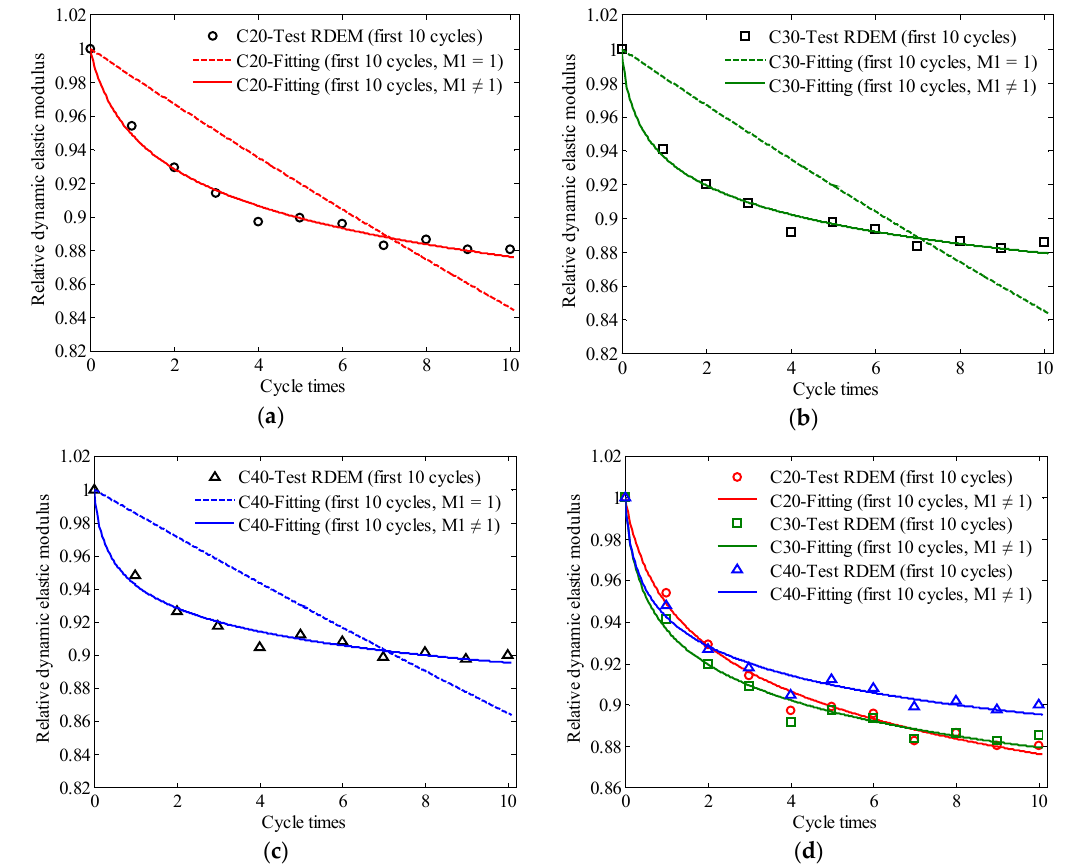
Figure 6. Fitting results of dynamic elastic modulus degradation model based on the initial and first 10 instances of periodic temperature-humidity action: ( a ) C20; ( b ) C30; ( c ) C40; ( d ) two-parameter degradation model for concrete with strength grades of C20, C30, and C40. (Note: C20, C30 and C40 means the concrete with different strength grade of 20MPa, 30MPa and 40MPa; ‘Test RDEM’ means the data is from the relative dynamic elastic modulus test results; ‘Fitting’ means the data is from fitting analysis; ‘M1 = 1’ means the fitting analysis is based on the single parameter model, see Equation (11); ‘M1 (cid:44) 1’ means the fitting analysis is based on the two-parameter model, see Equation (12), ‘first 10 cycles’ means the data analyzed are form the dynamic elastic modulus test after first 10 times periodic temperature-humidity action cycles). Table 7. Fitting parameters of the dynamic elastic modulus degradation model.